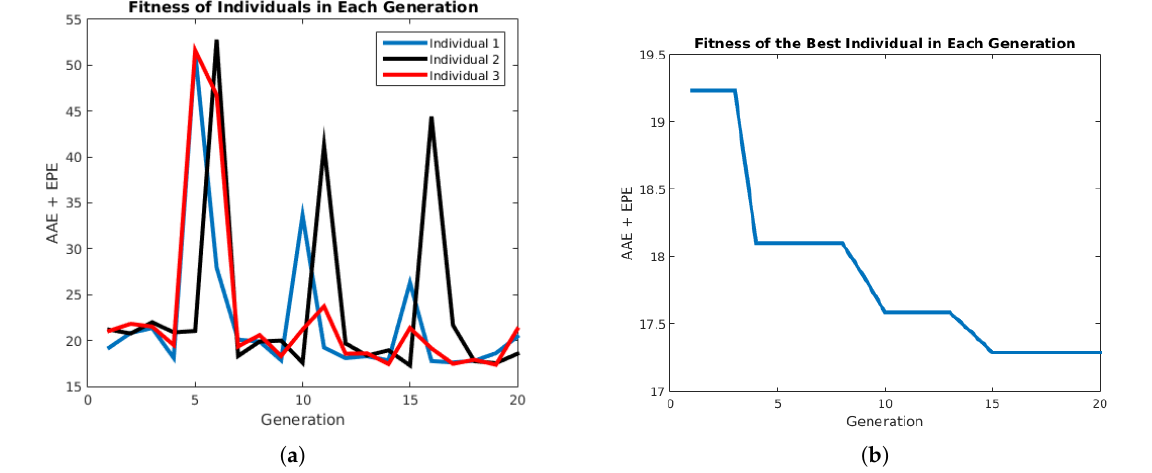
Figure 14. Performance of the PSO algorithm. ( a ) Performance of each individual. ( b ) Performance of the best individual in each generation.